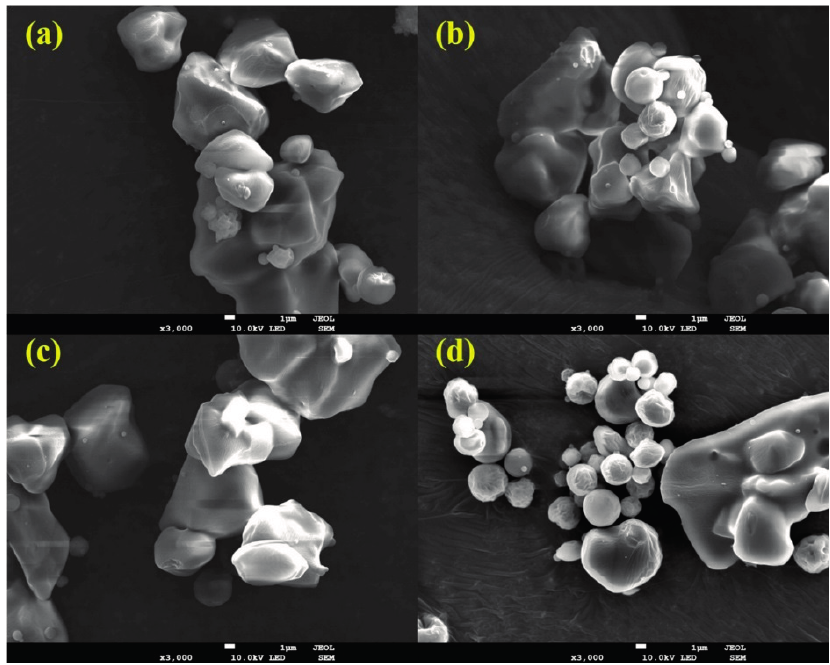
Figure 2. Scanning electron micrographs of sirolimus-loaded solid dispersions. ( a ) Sirolimus/E-SD solid dispersion (1/9); ( b ) Sirolimus/E-SD/TPGS solid dispersion (1/8/1); ( c ) Sirolimus/E-SD/HPMC solid dispersion (1/8/1); ( d ) Sirolimus/HPMC/TPGS solid dispersion (1/8/1). Total magnification of 3000× with a scale bar corresponding to 1 μ